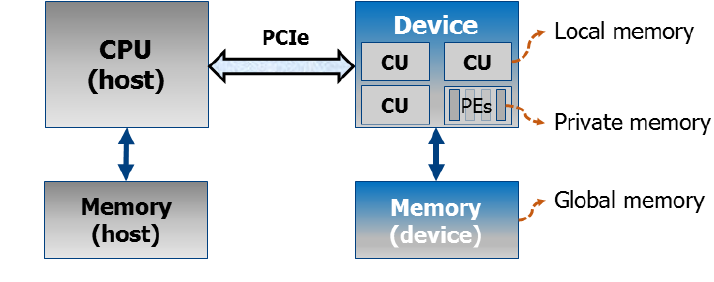
Figure 3. Basic OpenCL architecture, including the basic memory hierarchy. CPU = Central Processor Unit, CU = Compute Unit, PE = Process Element. The communication host–device is performed (in this case) via Peripheral Component Interconnect Express